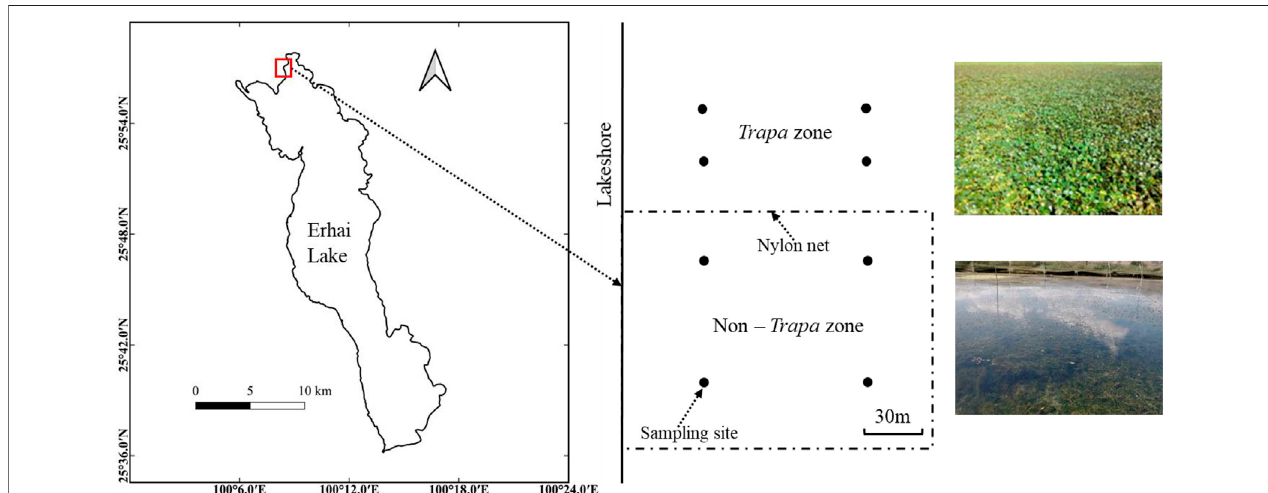
FIGURE 1 | Sketch map of study area